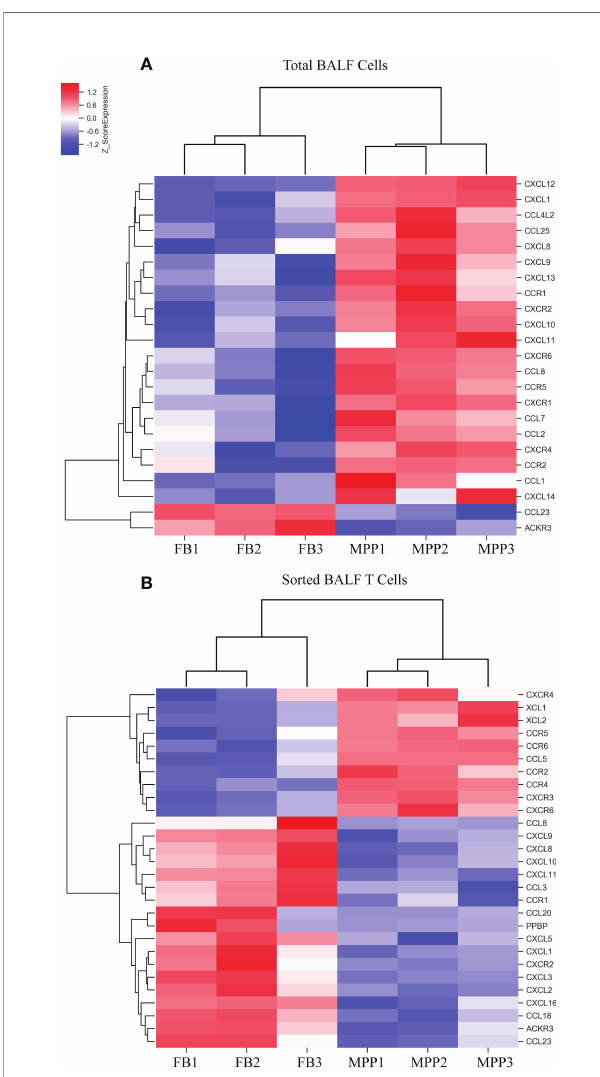
FIGURE 4 | DEGs of chemokines from microarray results were represented as heat maps. Colors indicate relative expression levels. The gradient color from red to blue means expression of the listed gene from upregulation to downregulation. Gene names of DEGs are listed on the right. Similar pattern of expression are clustered closer with linked line. (A) The heat map for DEGs of chemokine gene in BALF cells. Each sample represents BALF cells from an individual patient or FB control. (B) The heat map for DEGs of chemokine gene in sorted CD3+ T cells. Each sample represents sorted CD3+ T cells from an individual patient or FB control.